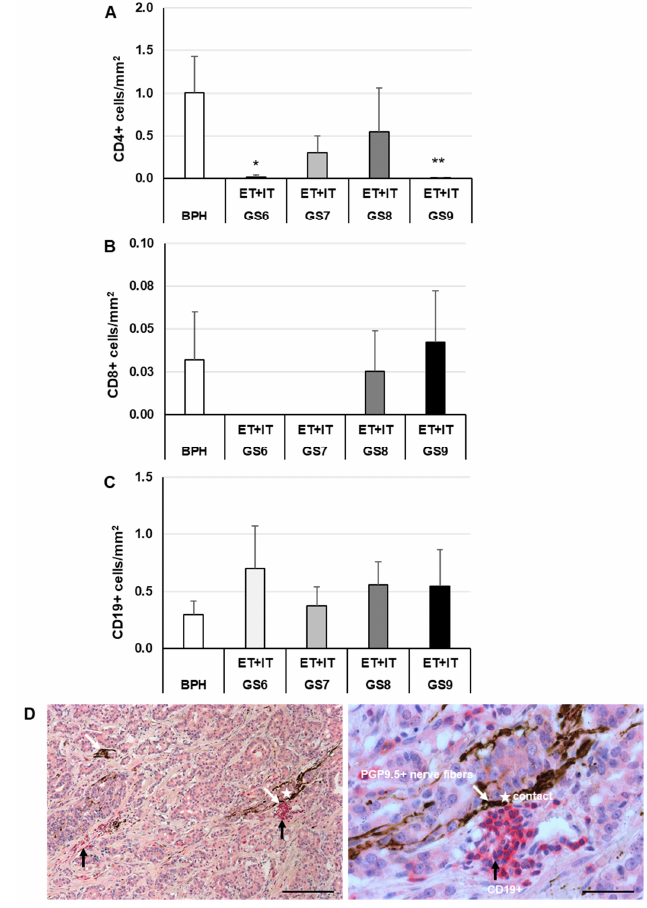
Figure 8. IHC of lymphocytes and nerve fibers in human BPH and extratumoral [ET] or intratumoral [IT] PCa regions. ( A ) Density of CD4+, T helper cells; ( B ) of CD8+, cytotoxic T cells; and ( C ) density of CD19+, B lymphocytes. The data show means + SEM; significance: * p ≤ 0.05, ** p ≤ 0.01, vs. BPH. (D) Representative photos of the contact (white star) between B lymphocytes (CD19+) and PGP9.5+ nerve fibers in PCa. The white arrows mark PGP9.5+ nerve fibers and black arrows mark clusters of B lymphocytes (CD19+). Nuclei were stained with hematoxylin. Scale bar from left to right 200 and 100 µm.